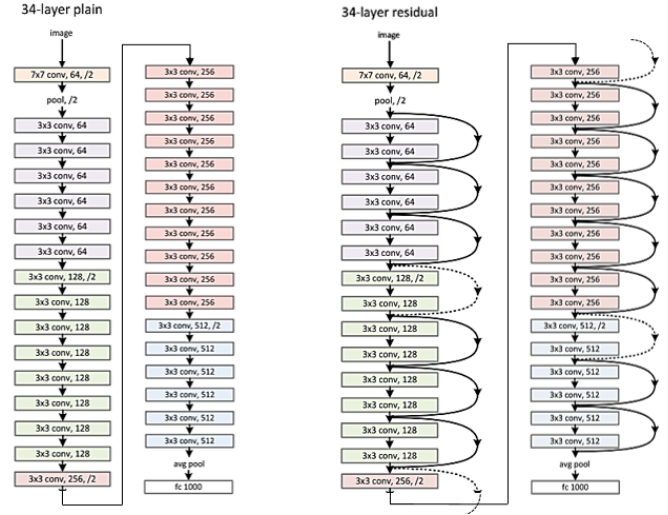
Figure 14. Network architecture for plain network with 34 parameter layers and residual network with 34 parameter layers [142].